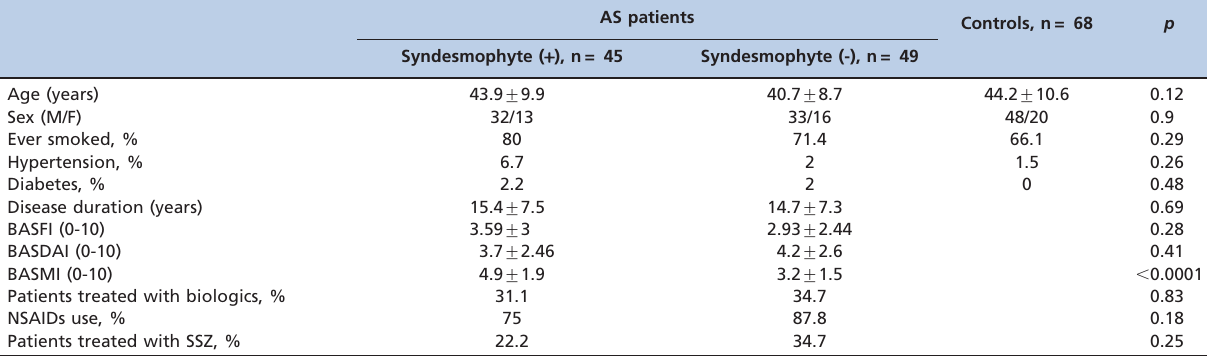
Table 1 - Demographic and clinical characteristics of the study group.